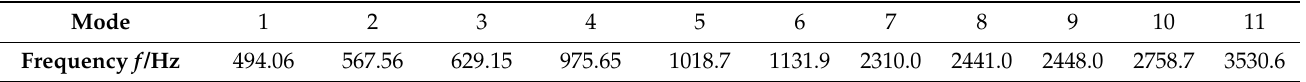
Table 4. The simulated resonance frequency of the original configuration.